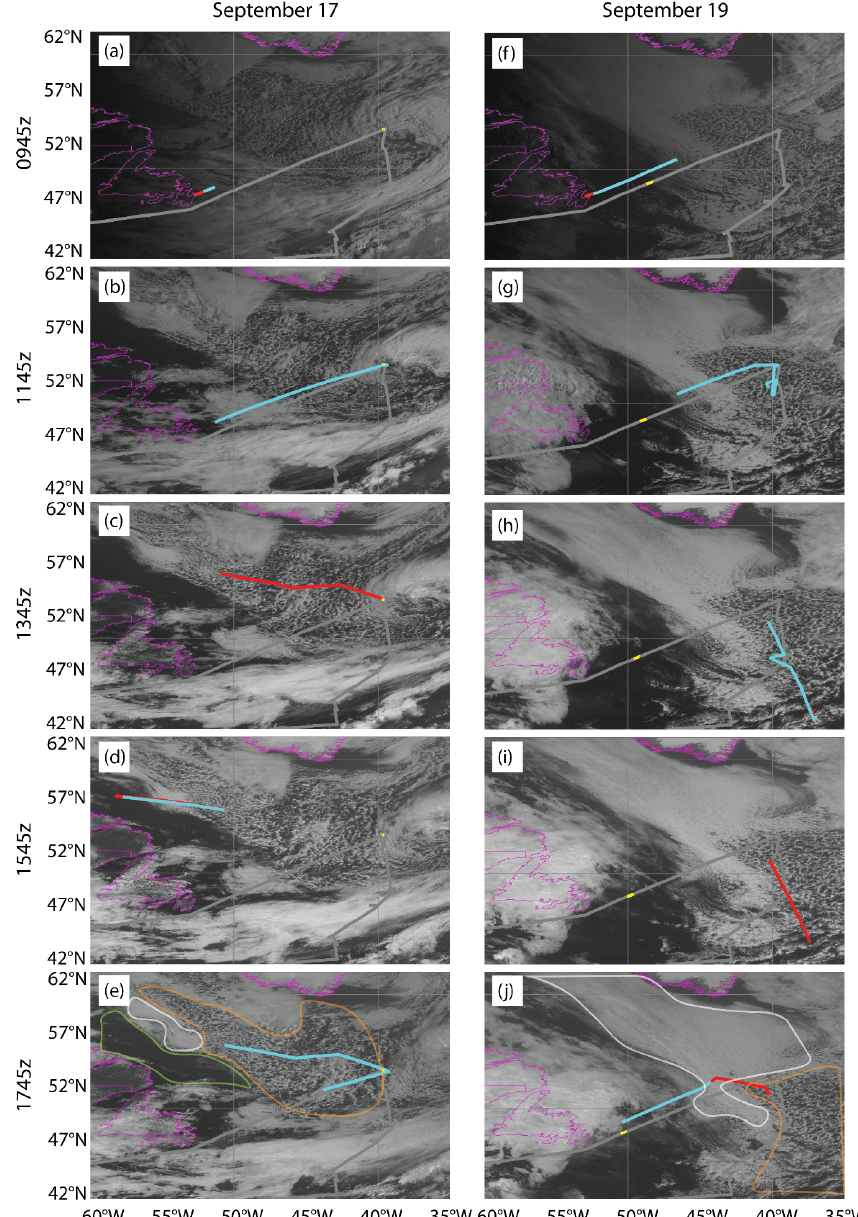
Figure 1. GOES-East visible satellite imagery at 2h intervals for 17 September 2017 (a–e) and 19 September 2017 (f–j) . Purple lines outline the coast of eastern Canada and the southern tip of Greenland. Cyan and red lines represent the flight track at altitudes > 3km and < 3km, respectively, ± 1h from the satellite image time (shown on the y axis). The yellow line represents the ship position ± 1h from the satellite image time. The gray line is the entire ship track for the NAAMES3 campaign. (e, f) The cloud-free, closed-cell, and open-cell regions of interest are shown with approximate outlines in green, white, and orange,